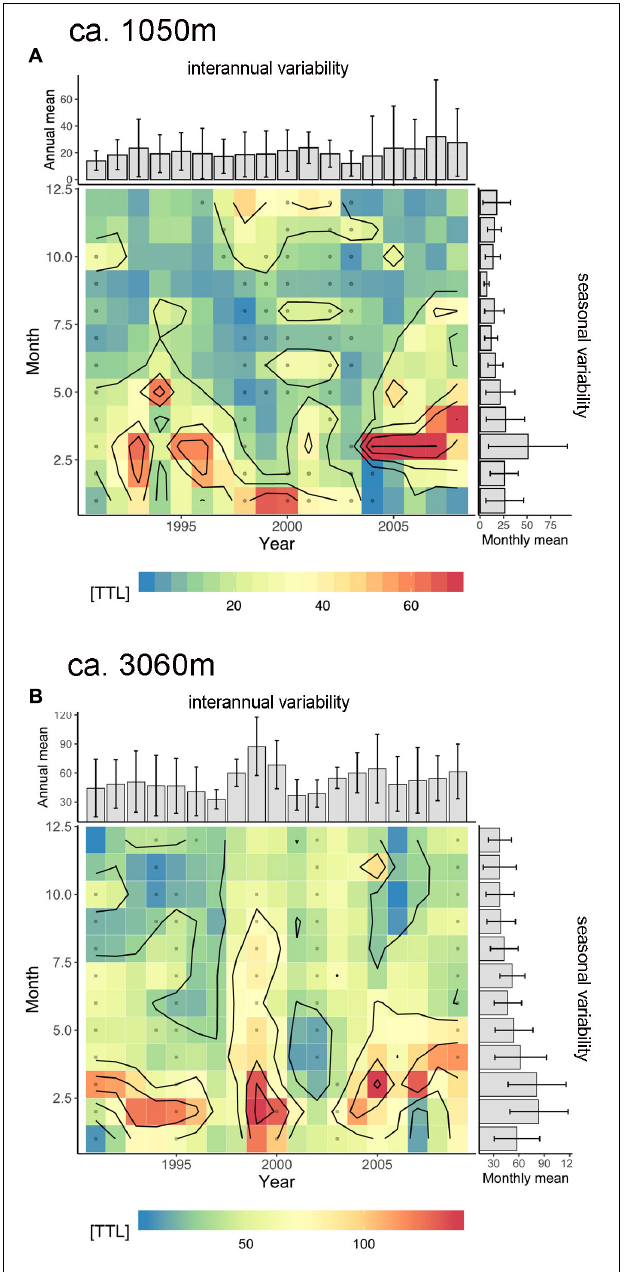
FIGURE 10 | Seasonality vs. long-term variability of total mass flux (TTL, mg m − 2 d − 1 ) in the upper ( A: ca. 1 km) and deeper ( B: ca. 3 km) trap level. Note a change in seasonality from late winter to early spring (Feb/Mar to Mar/Apr) on the long-term (mainly in the 1 km trap) and the increasing fluxes. Extraordinary high fluxes from 1998 to 2000 in ca. 3 km (B) are hypothesized to be caused by the extreme ENSO event and its effect on coastal upwelling. Gray dots represent the squares interpolated by the Barnes